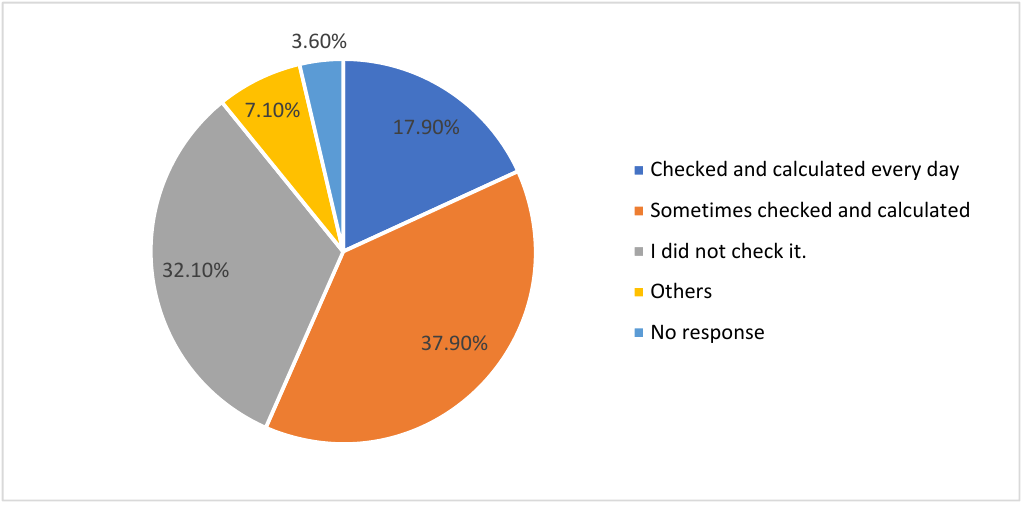
Figure 8. Frequency of calculation of remaining point.